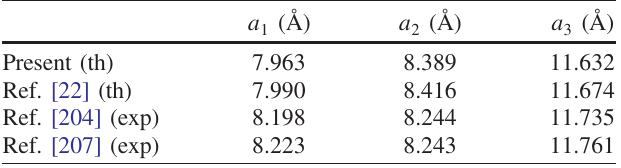
TABLE III. Lattice parameters of orthorhombic CsPbBr 3 , obtained by first-principles simulations or experiments [22,207]. The directions ˆ x , ˆ y , and ˆ z discussed, e.g., in Fig. 6, refer respectively to lattice vectors a 1 , a 2 , and a 3